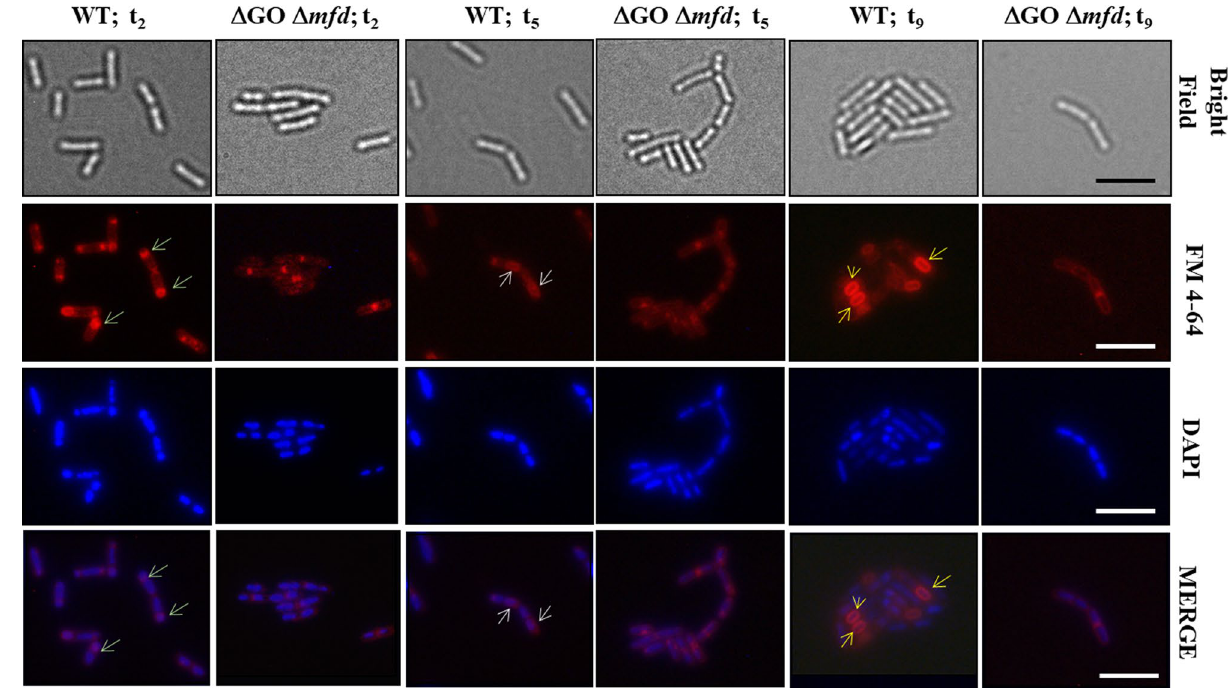
Figure 6. Epifluorescence microscopic analysis of sporulation stages of B. subtilis strains with a wild type (WT) or ∆ mfd /∆GO genotype. The strains indicated were induced to sporulate in DSM. At the indicated stages (t 2 , t 5 and t 9 ), cells were collected, fixed and analyzed by bright- field (BF) and fluorescence (DAPI and FM4-64 staining) microscopy as described in “Materials and methods” section. Overlain images of DAPI and FM4-64 at each time point are depicted as MERGE. Yellow arrowheads show the proper development of the forespore in the WT strain during the stages analyzed. The scale bar is 5 μm and all images are at the same magnification.